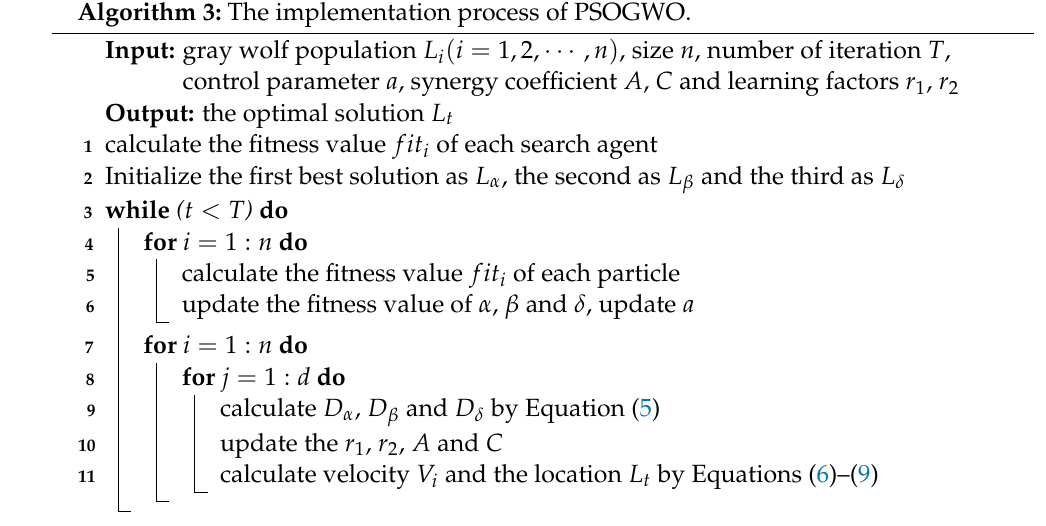
Algorithm 3: The implementation process of